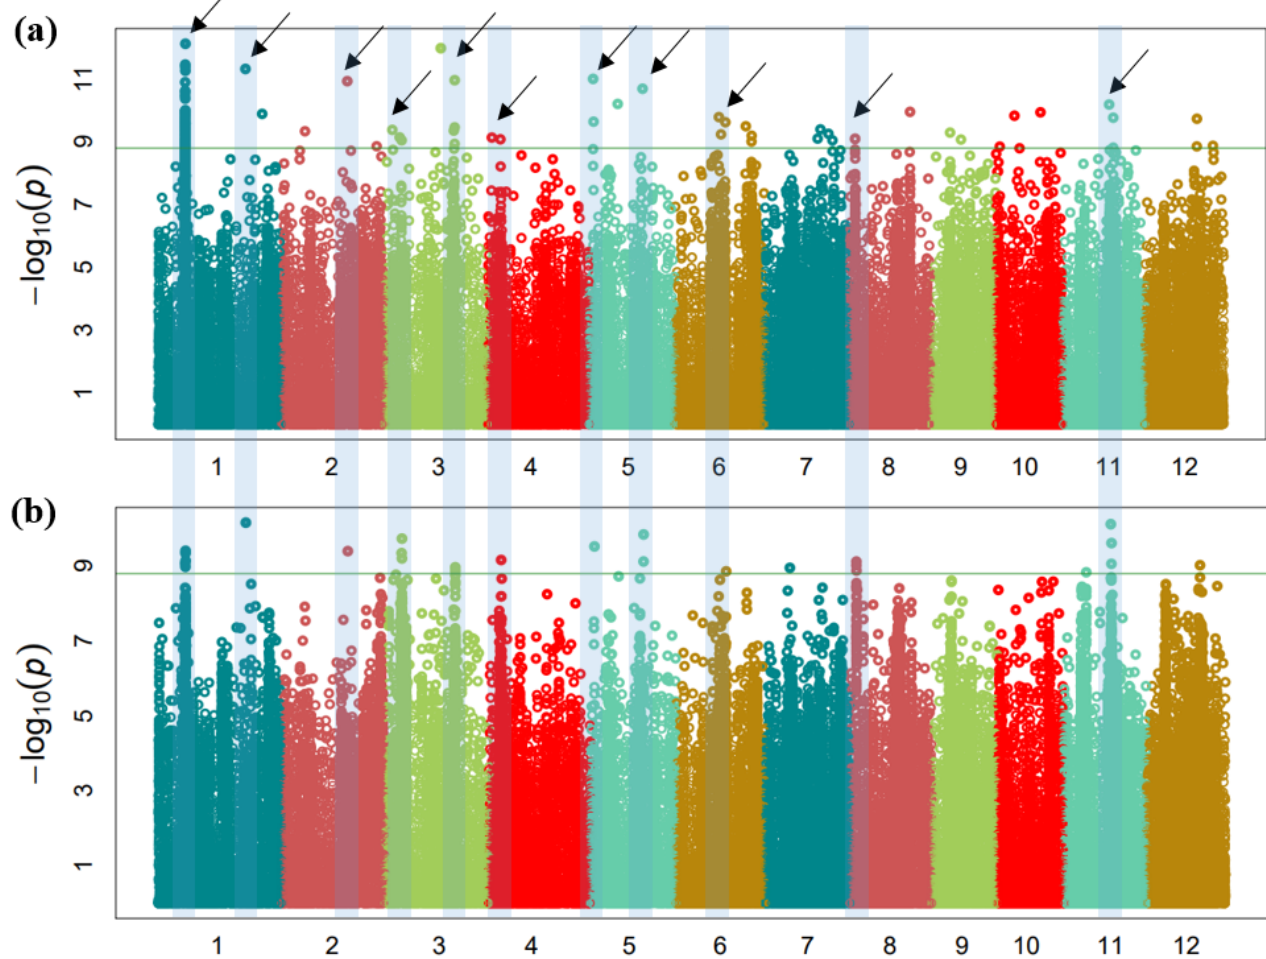
Figure 3. Manhattan plots for mesocotyl length in 137 rice vatieties. ( a ) GWAS of first repetition for evaluation of mesocotyl elongation length using the GAPIT. ( b ) GWAS of second repetition for evaluation of mesocotyl elongation length using the GAPIT. X axis indicates physically mapped chromosomes. Y axis indicates significance as calculated by − log10 ( p ). Blue bar indicates same position SNPs. Black arrows represent 11 overlapped lead SNPs detected in both replications.